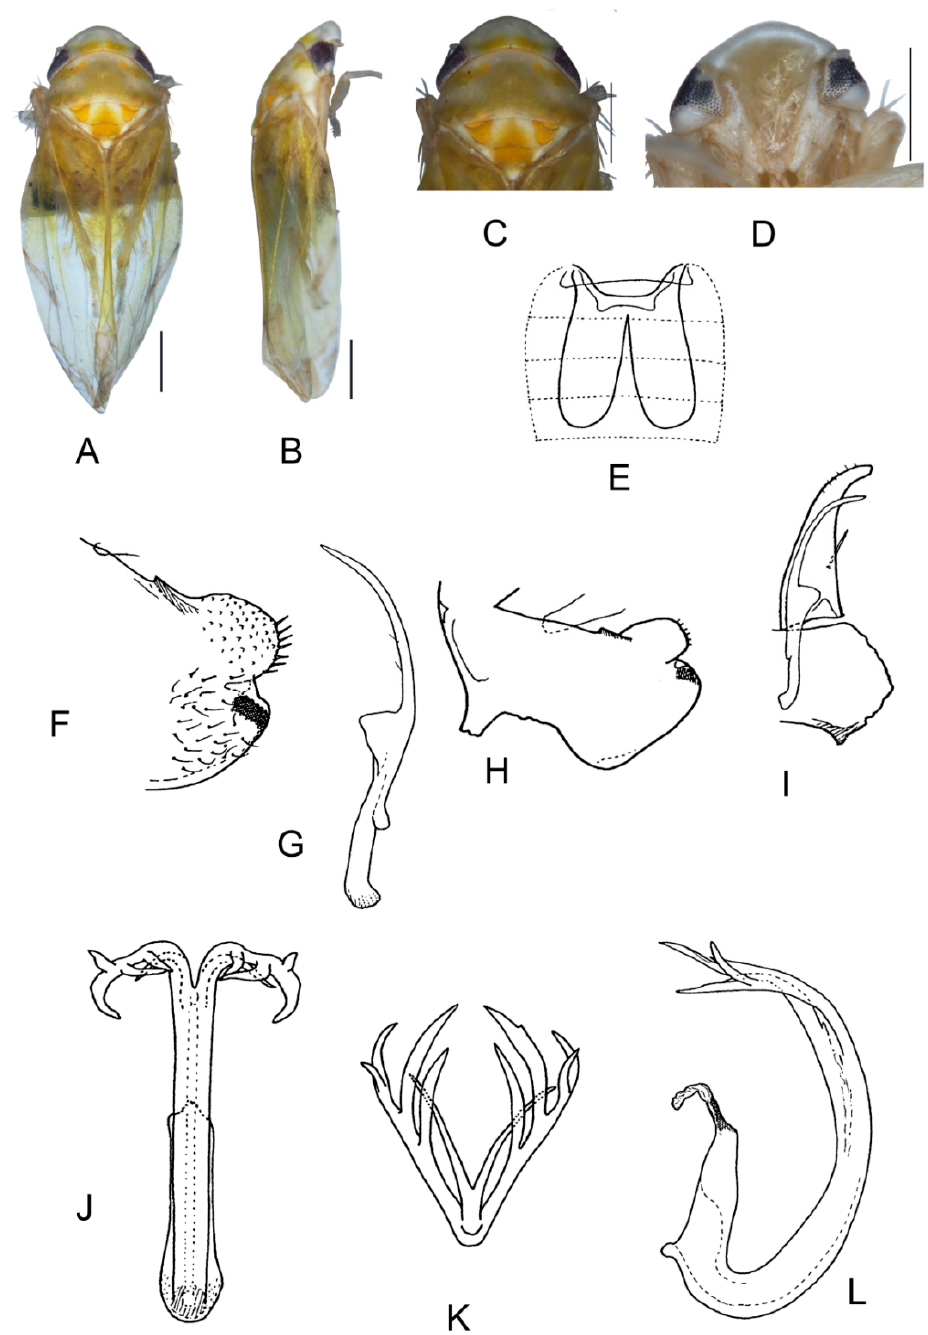
Figure 15. Eurhadina ( Singhardina ) fasciata rec. nov. ( E – L : Dworakowska, 2002 [3]): ( A ) habitus, dorsal view; ( B ) habitus, lateral view; ( C ) head and thorax, dorsal view; ( D ) face; ( E ) abdominal apodemes, dorsal view; ( F ) hind part of pygofer, lateral view; ( G ) paramere, dorsal view; ( H ) male pygofer side, lateral view; ( I ) subgenital plate, paramere and sternite IX, dorsal view; ( J ) aedeagus, posterior view; ( K ) apex of aedeagal shaft, dorsal view; and ( L ) aedeagus, lateral view. Scale bars: 0.5